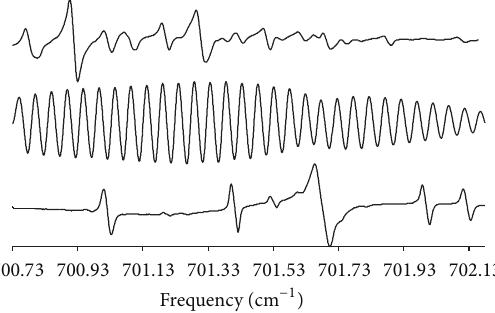
Figure 2: A representative spectral snippet from the nitrobenzene spectrum in the 14-micron region. This trace was recorded utilizing a Pb-salt diode laser spectrometer and a FM modulated detection scheme. There are 17 clearly defined rotationally resolved nitroben- zene transitions FM modulated signal shown in the top panel. The lowertracesarerecordedsimultaneouslywithsignalchannelandare used for frequency calibration